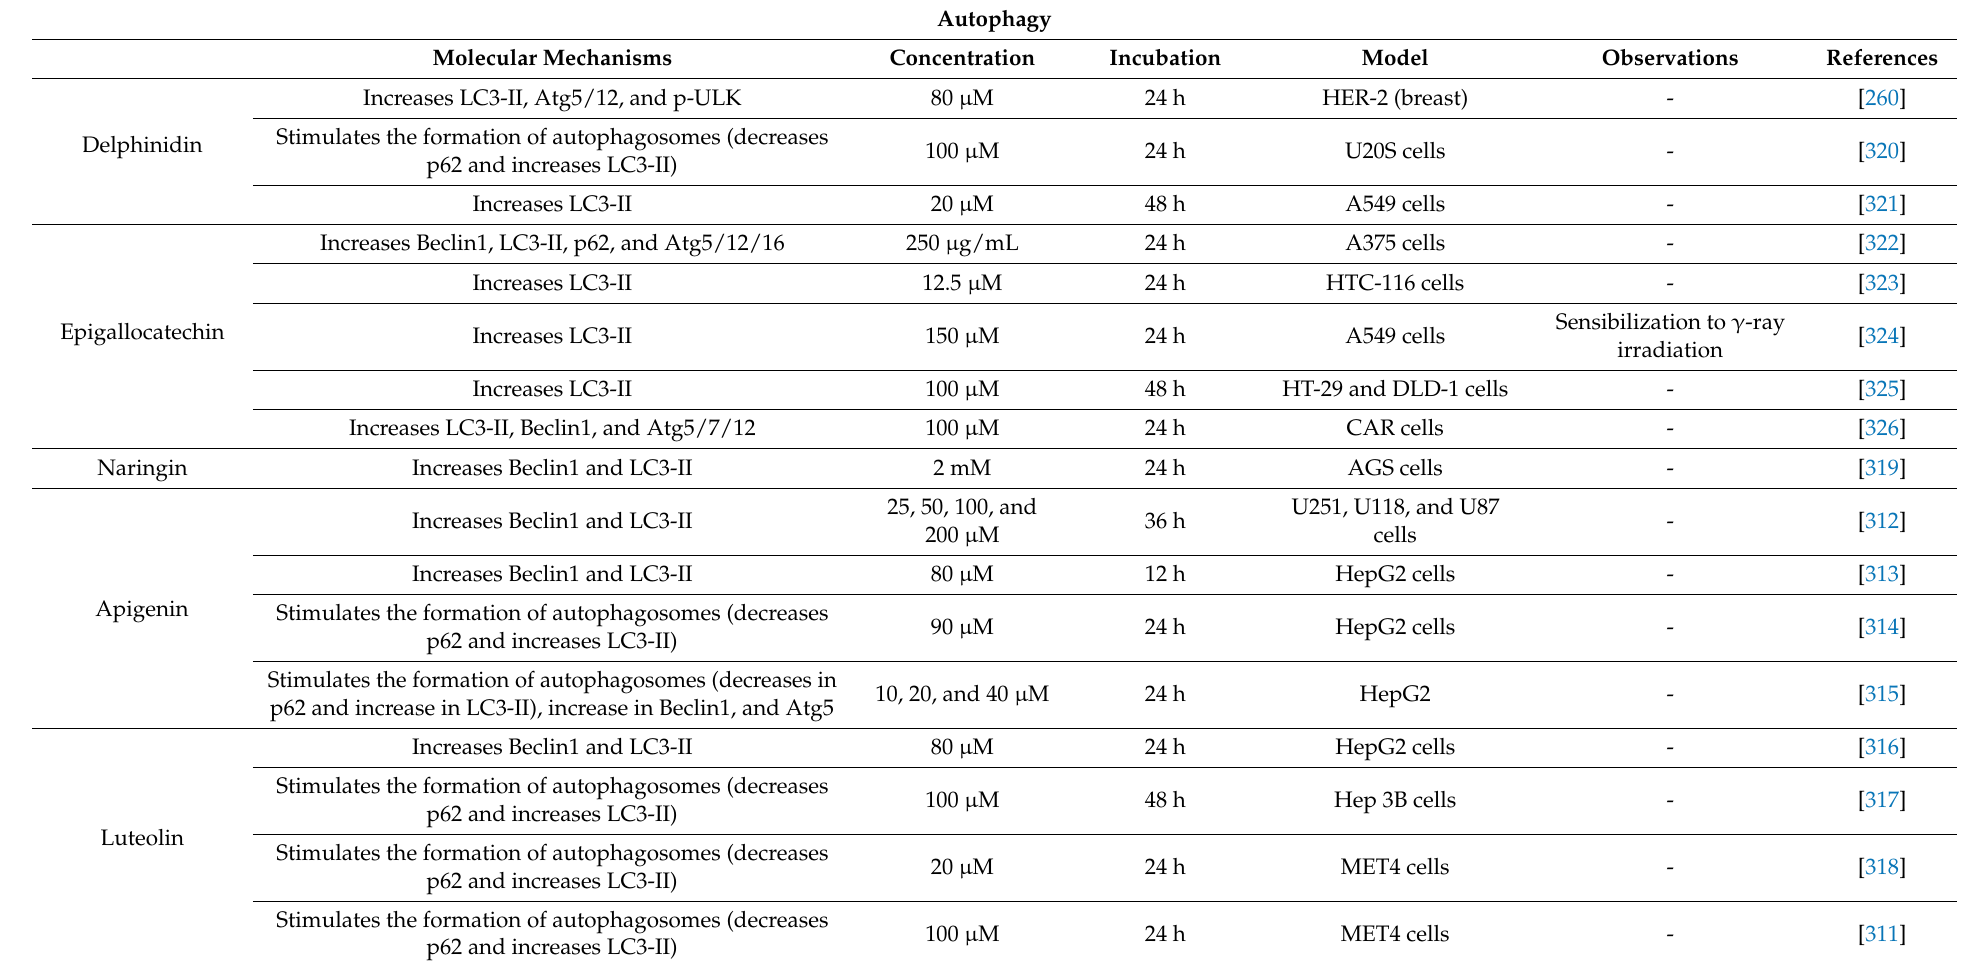
Table 6. Molecular mechanisms of flavonoids in autophagy and